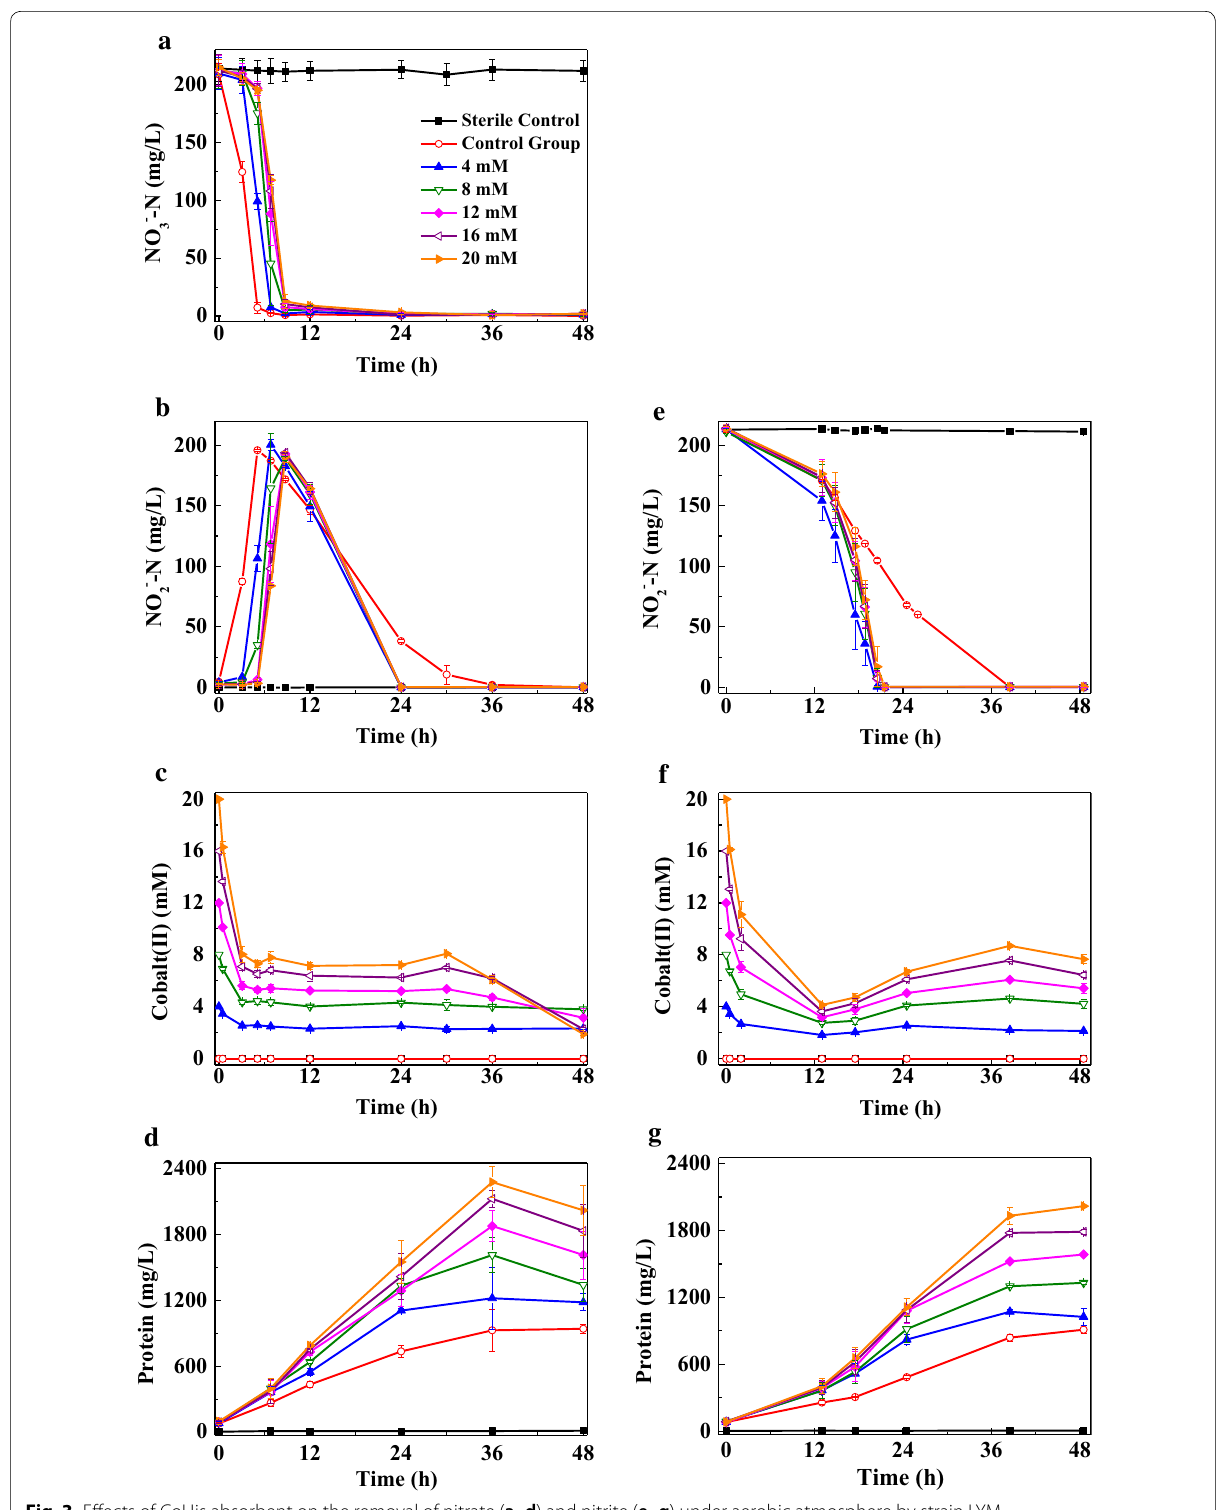
Fig. 3 Effects of CoHis absorbent on the removal of nitrate ( a – d ) and nitrite ( e – g ) under aerobic atmosphere by strain